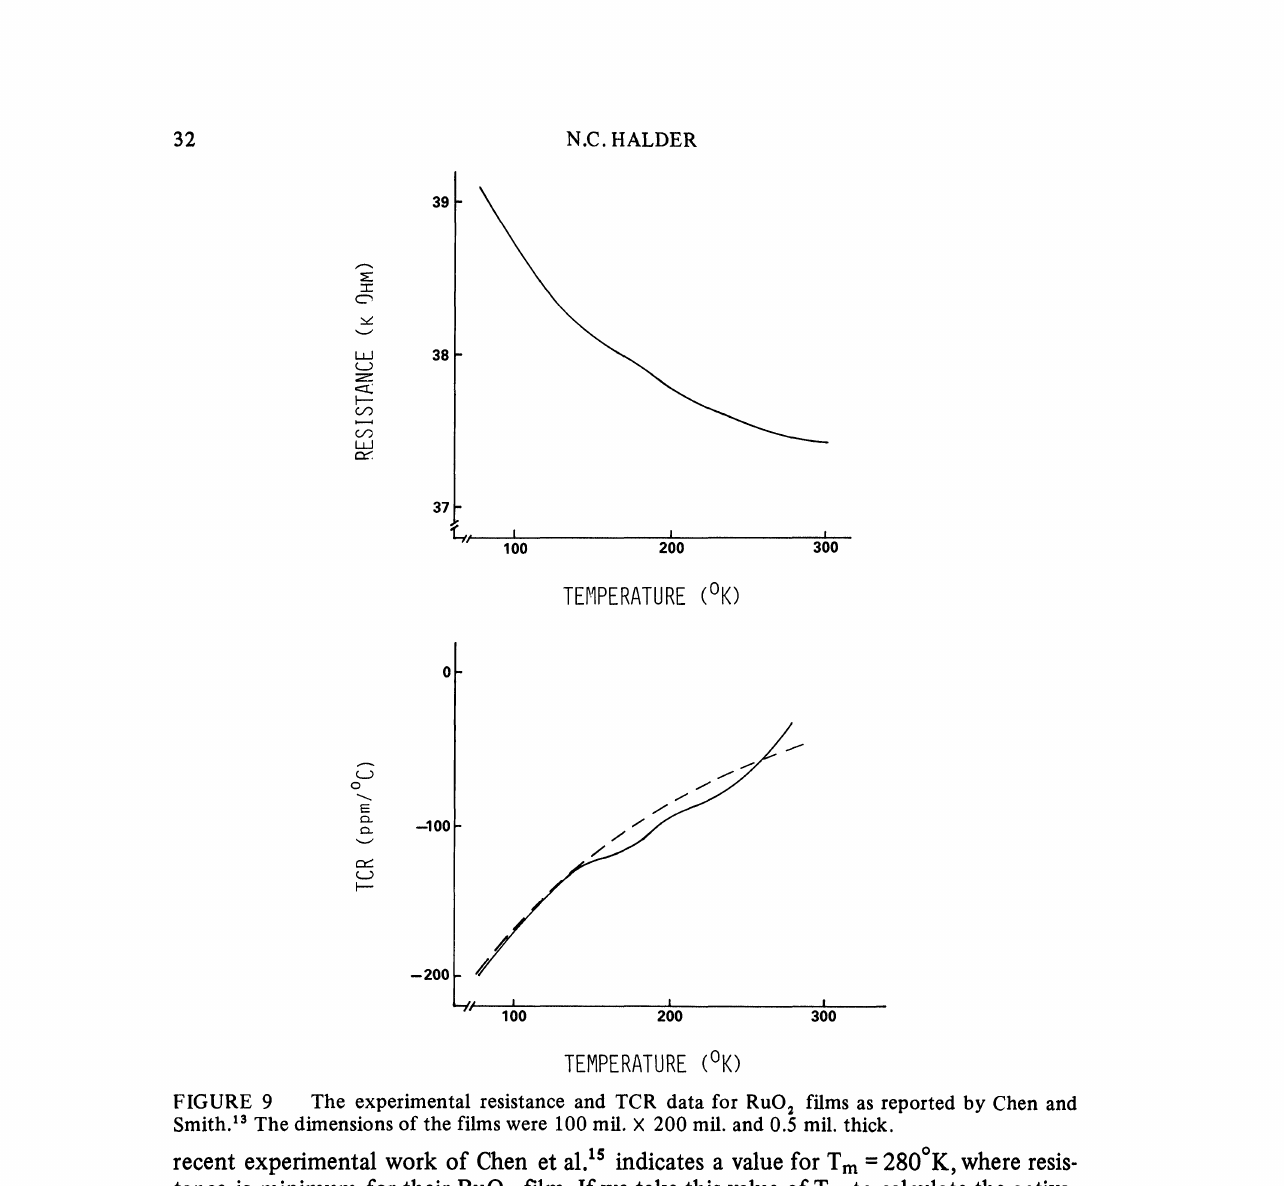
would indicate a possibility of only a resonance-type tunneling. The negative T energy curves (curve numbered 5) in Figures 7(a) and 7(b) indicate a situation for a parti- cular combination of the data t and #, which may not exist in an actual thick film